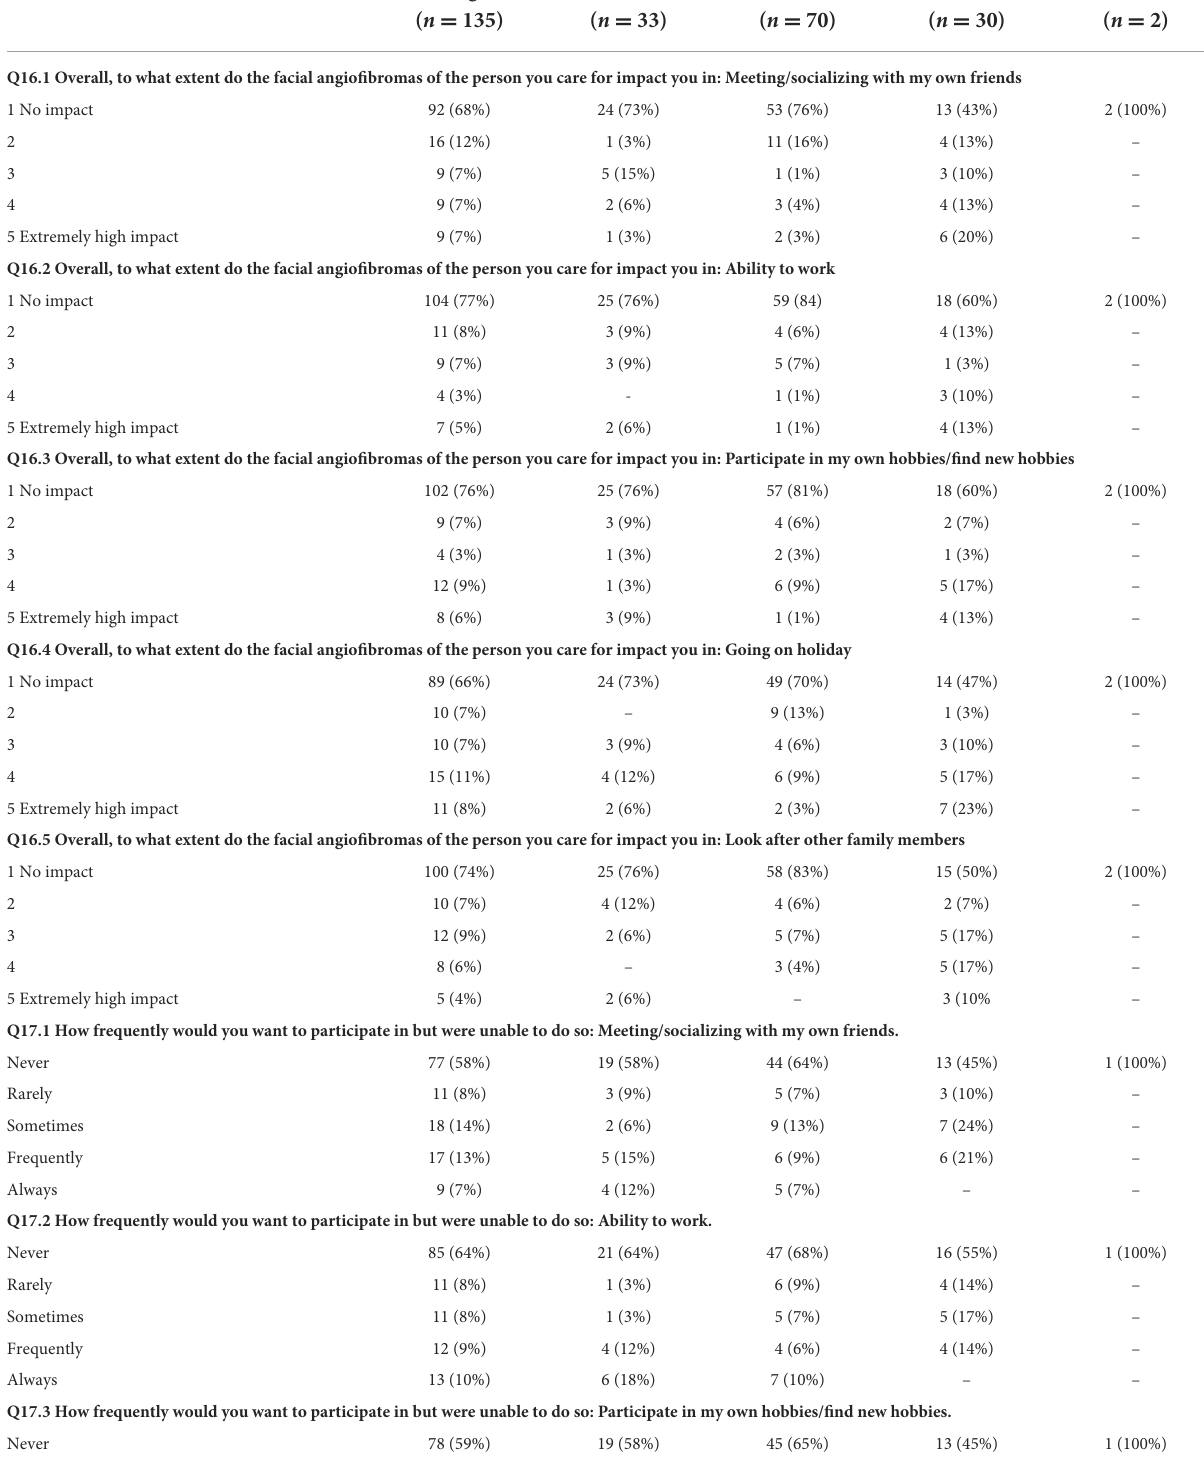
Severity of FAs in person cared for All caregivers